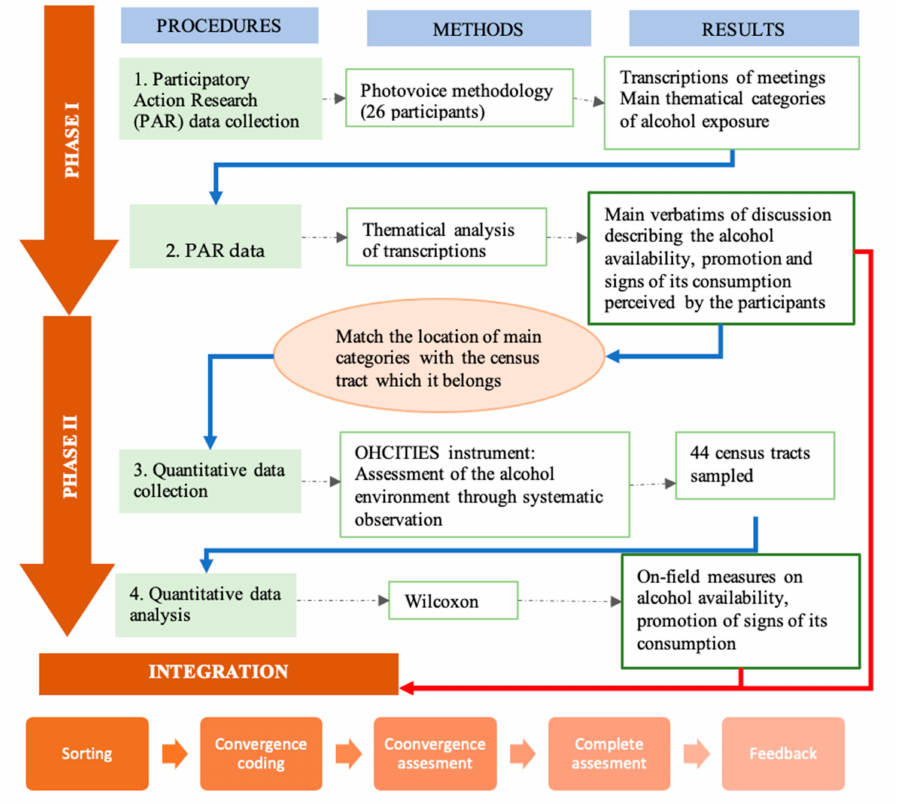
Figure 1. Flow diagram describing the mixed methods